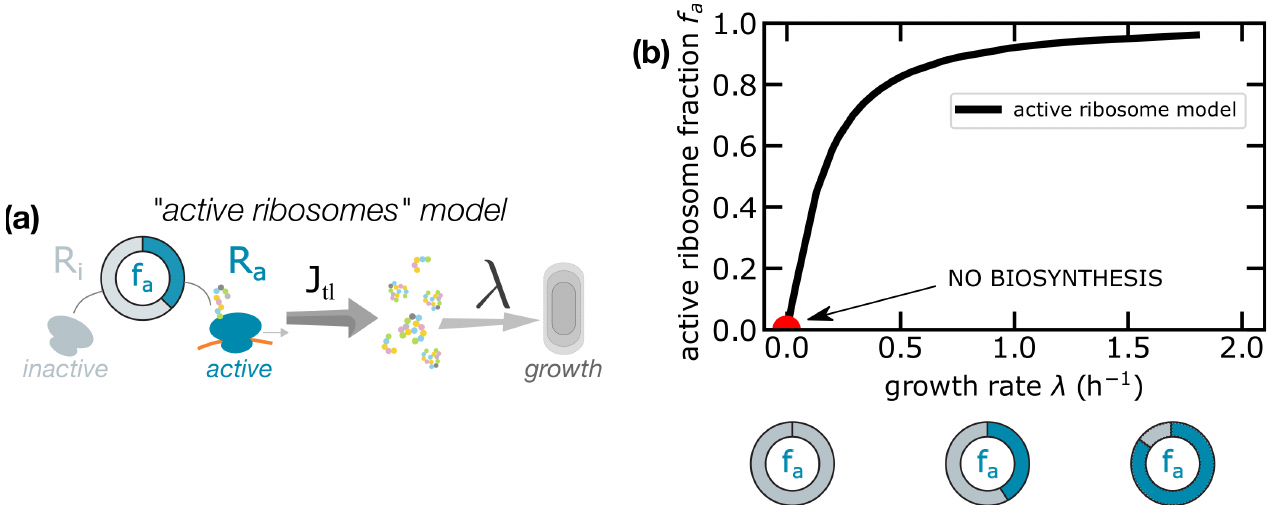
Fig 2. (a) The standard framework divides ribosomes into two categories—active and inactive—and assumes that only the fraction f a of active ribosomes is responsible for protein production. (b) The plot reports the estimated values f the extrapolated point at zero